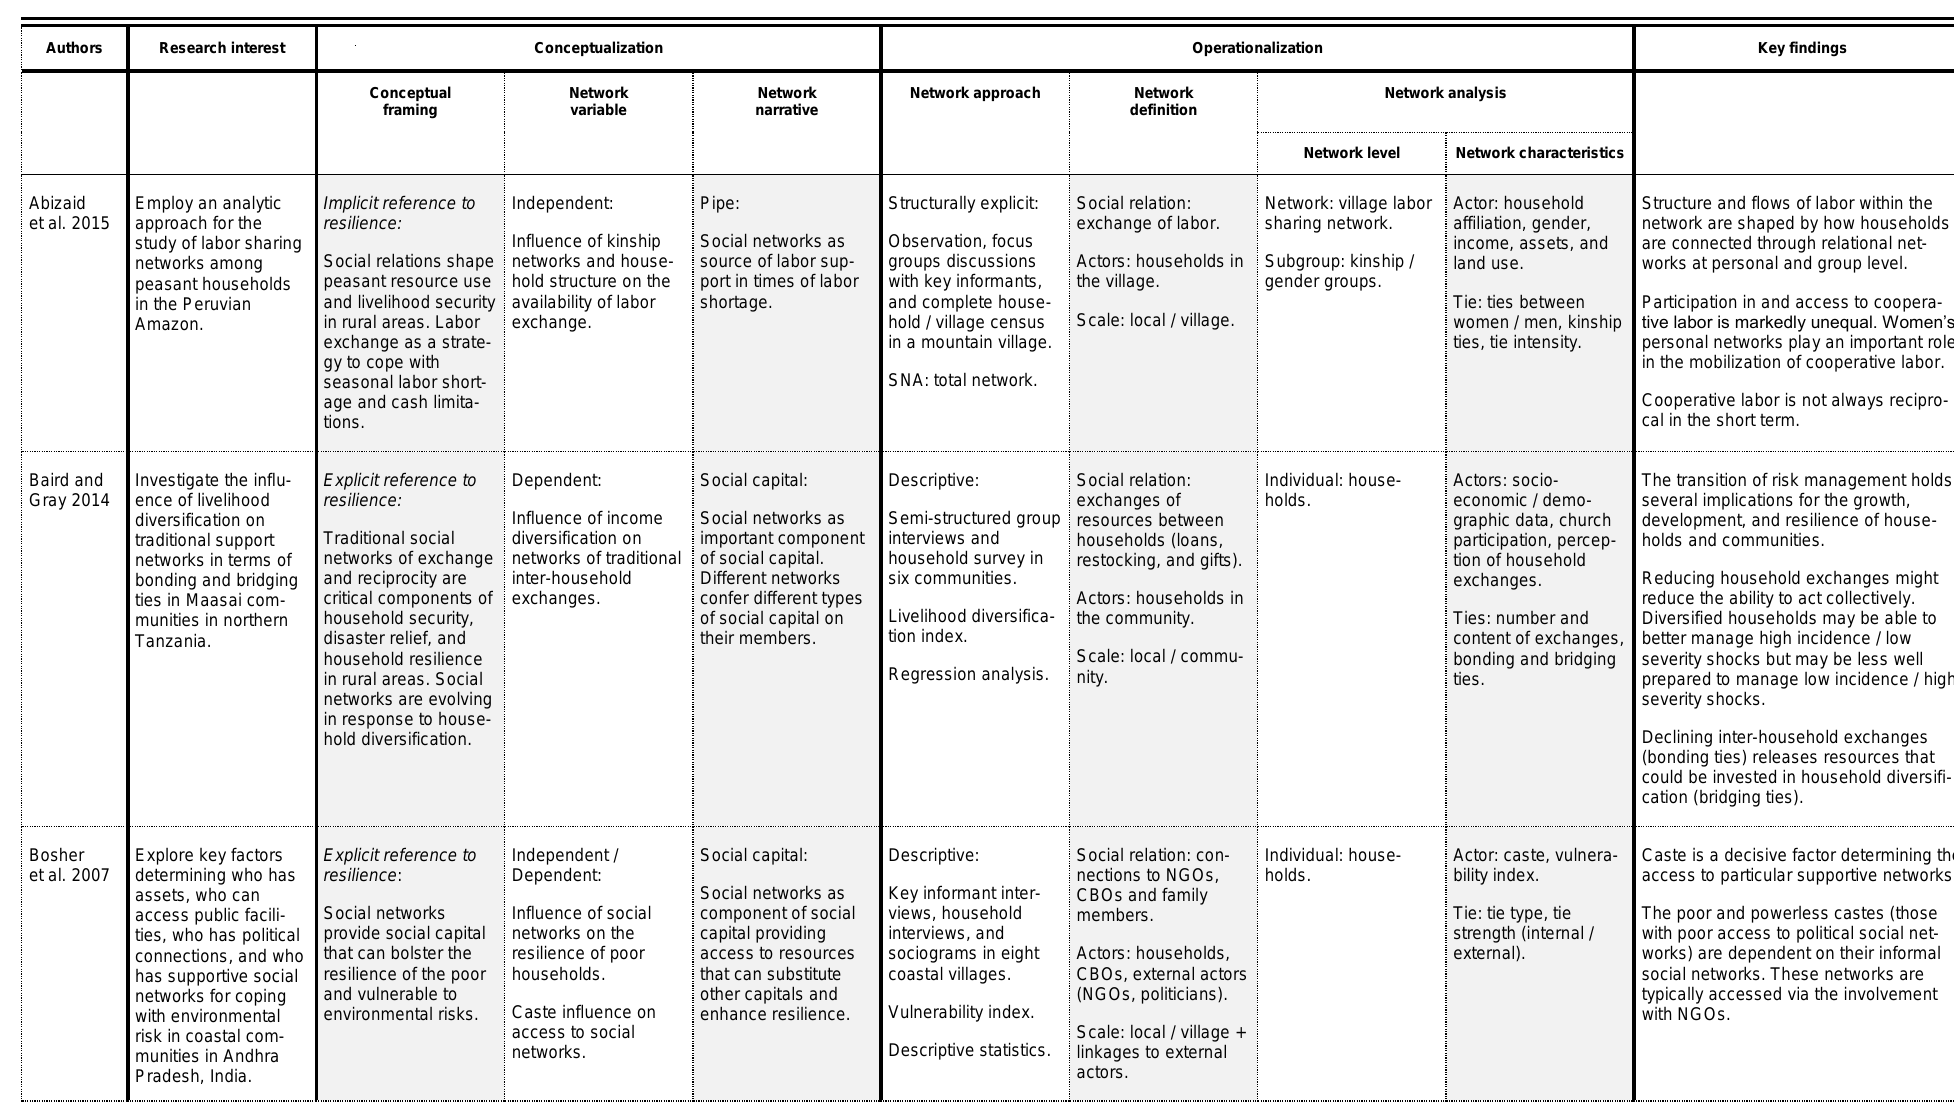
Table A1.3: Strand iii: Social